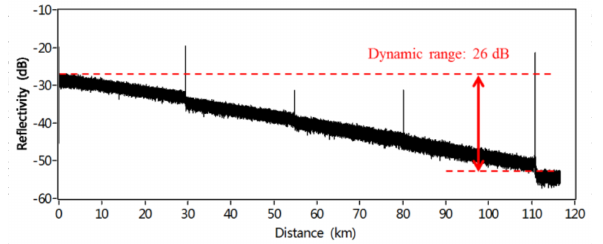
Figure 14. Measured trace of Rayleigh backscattering and Fresnel reflections along 110 km FUT (reprinted from Liu et al. [17] with permission of OSA; copyright (2015)).